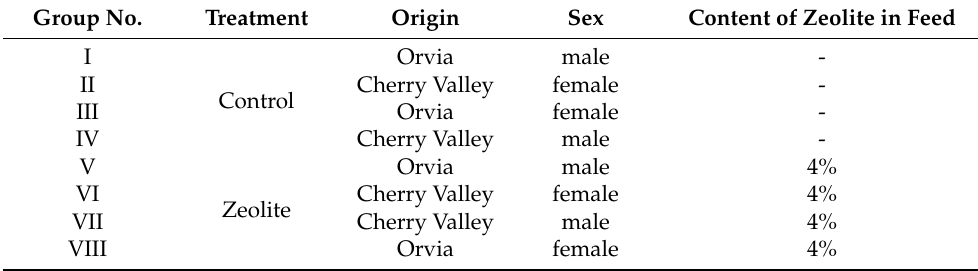
Table 1. Description of experimental groups of ducks. Group